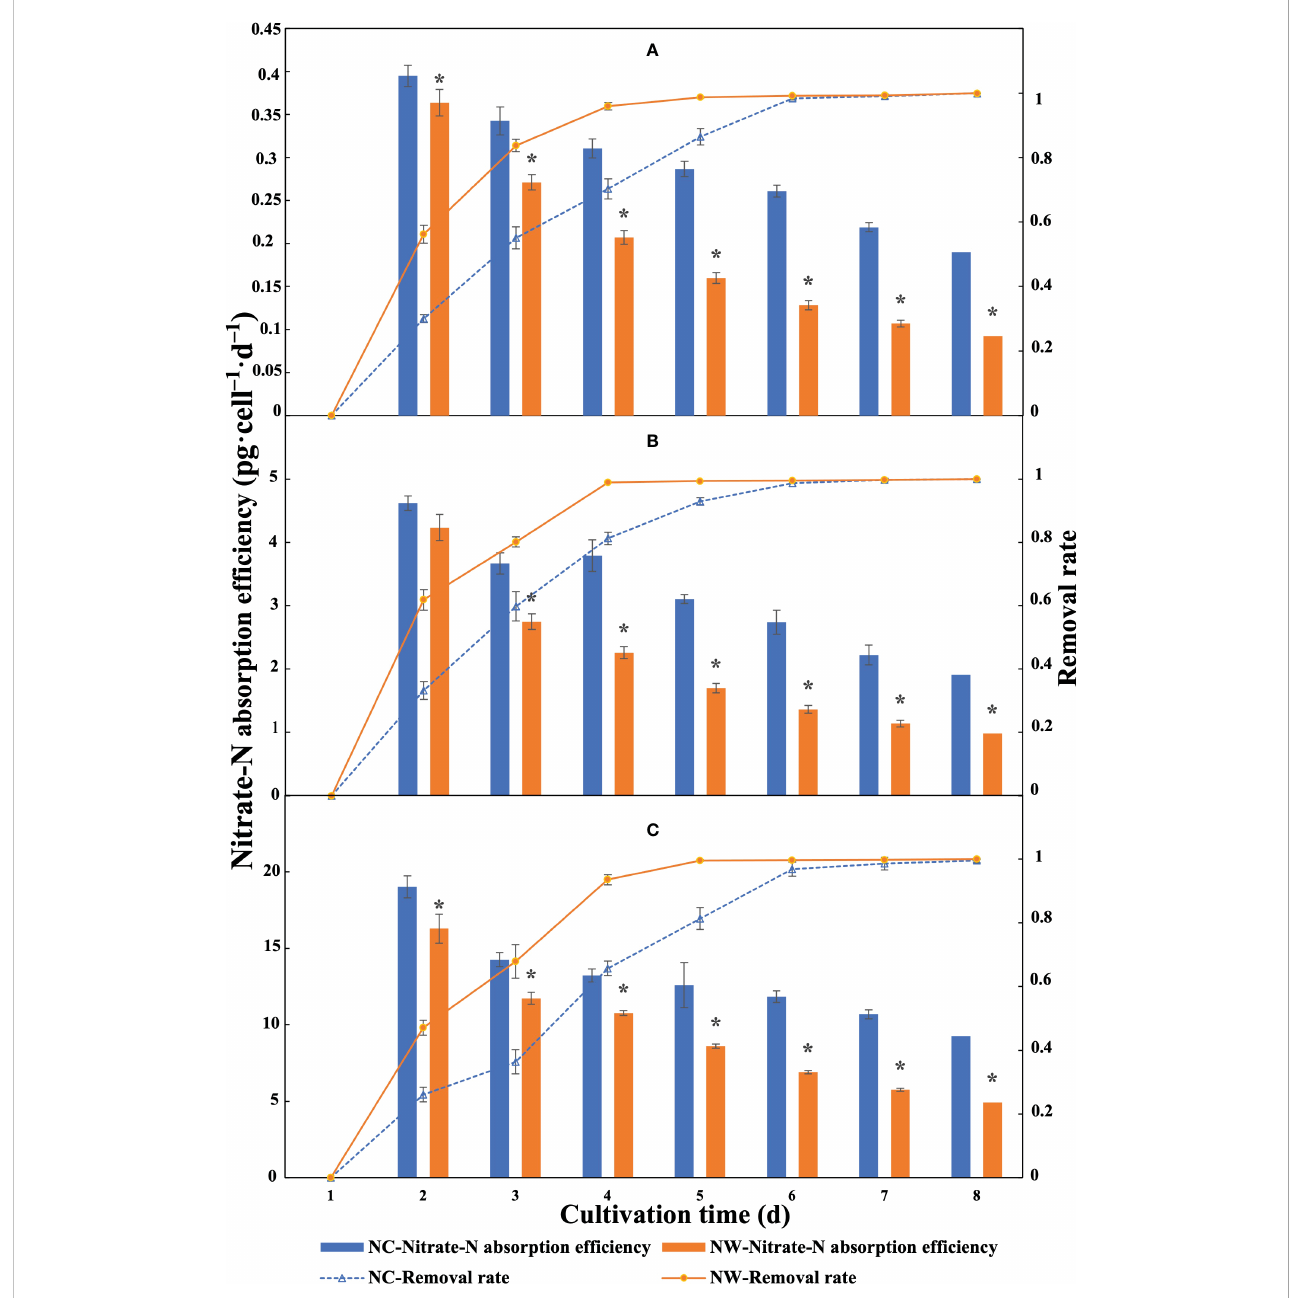
FIGURE 2 Nitrate-N absorption ef fi ciency and nitrate-N removal rate of N. oceanica (A) , C. atomus (B) , and C . weiss fl ogii (C) . NC, nitrate-N concentration of 13.85 mg·L – 1 . NW, nitrate-N concentration of 5 mg·L – 1 . The one-way ANOVA analysis and the Tukey ’ s post hoc test were executed to estimate the differences. “ * ” above the column indicates a signi fi cant difference ( P < 0.05) between NC and NW at the same timepoint. Data are displayed as the mean ± SD (standard deviation) (n =